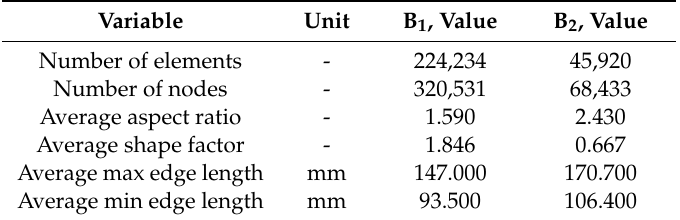
Table 6. Statistics of the discrete mesh associated with the bounding boxes B 1 and B 2